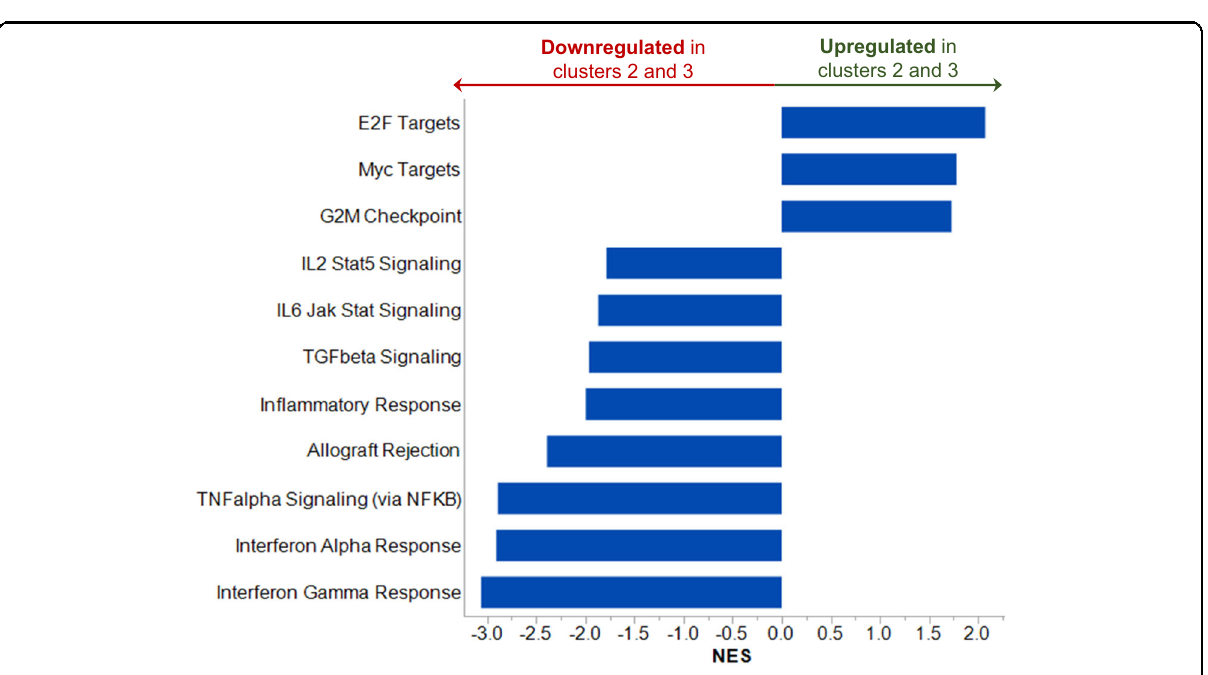
Fig. 5 The mean normalized enrichment score (NES) of Hallmark pathways with FDR q value < 0.05 when comparing gene expression in the immune clusters 2 and 3 versus cluster 1 are represented by each bar. NES < 0 represents downregulation of speci fi ed pathway in immune clusters 2 and 3, versus cluster 1. NES > 0 represents upregulation of speci fi ed pathway in immune clusters 2 and 3, versus cluster